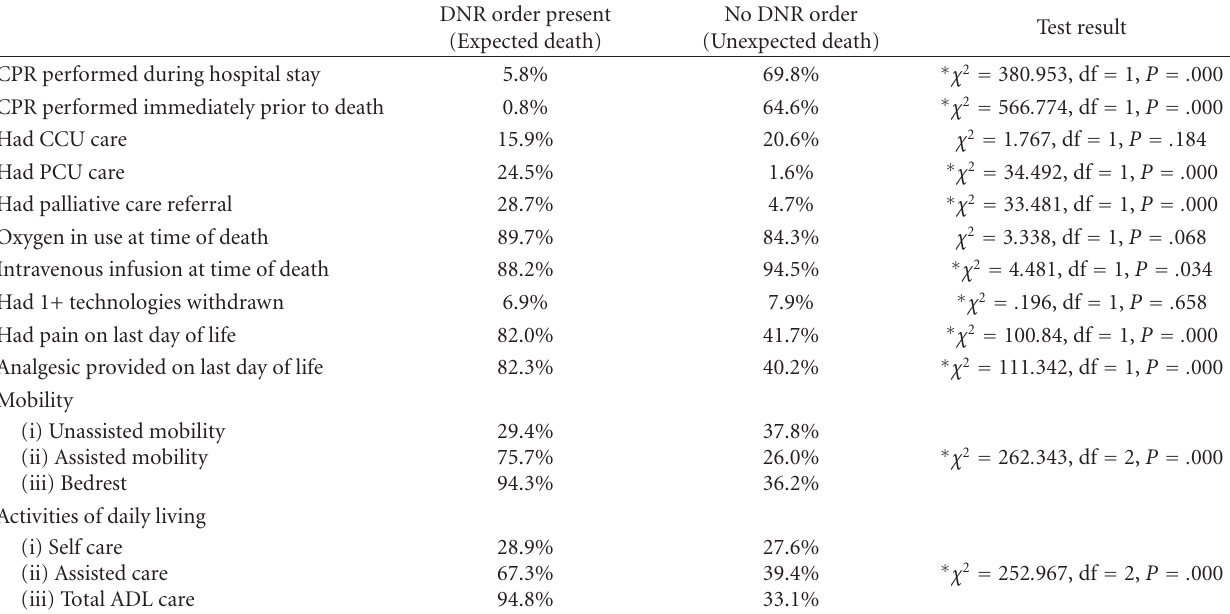
Table 3: Care needs and provided care findings in relation to expected versus unexpected